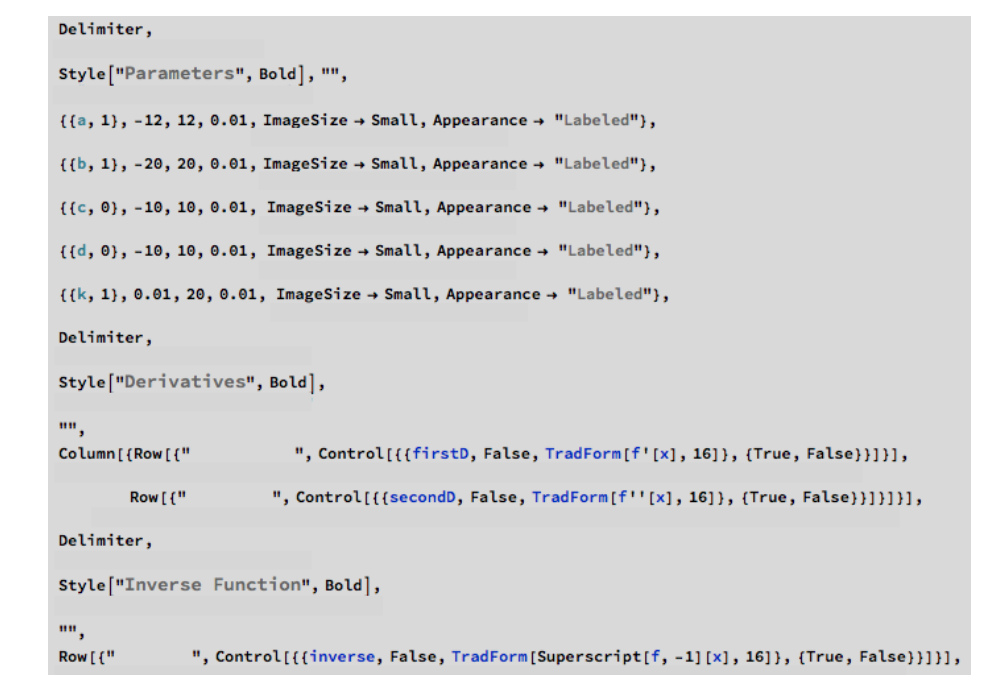
Figure 3. Part of the code of the “F-Logistic” tool [35] responsible for some checkboxes for the plots’ options and for the parameter values (including the choice of styles and sizes).